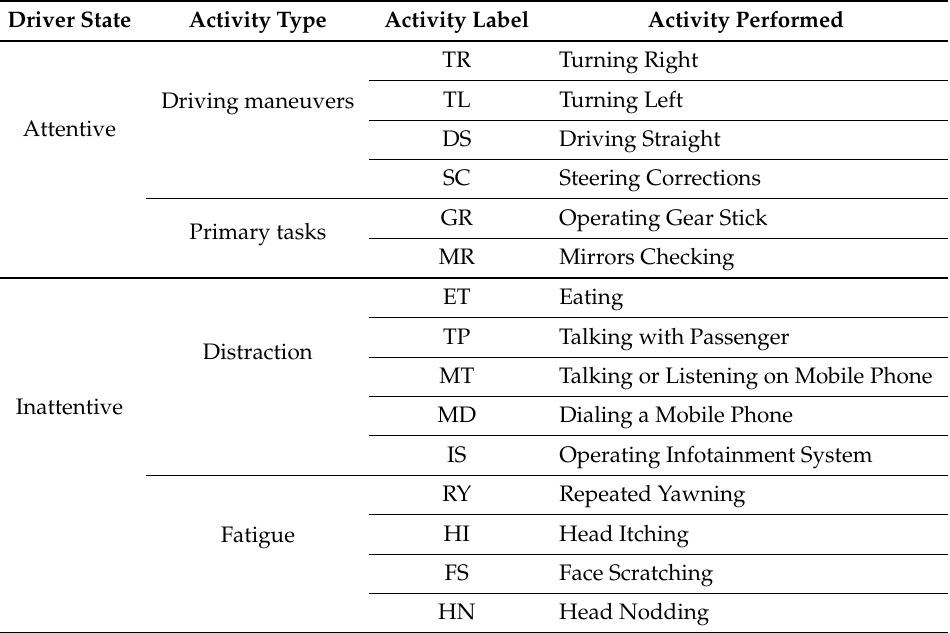
Table 1. Proposed activities